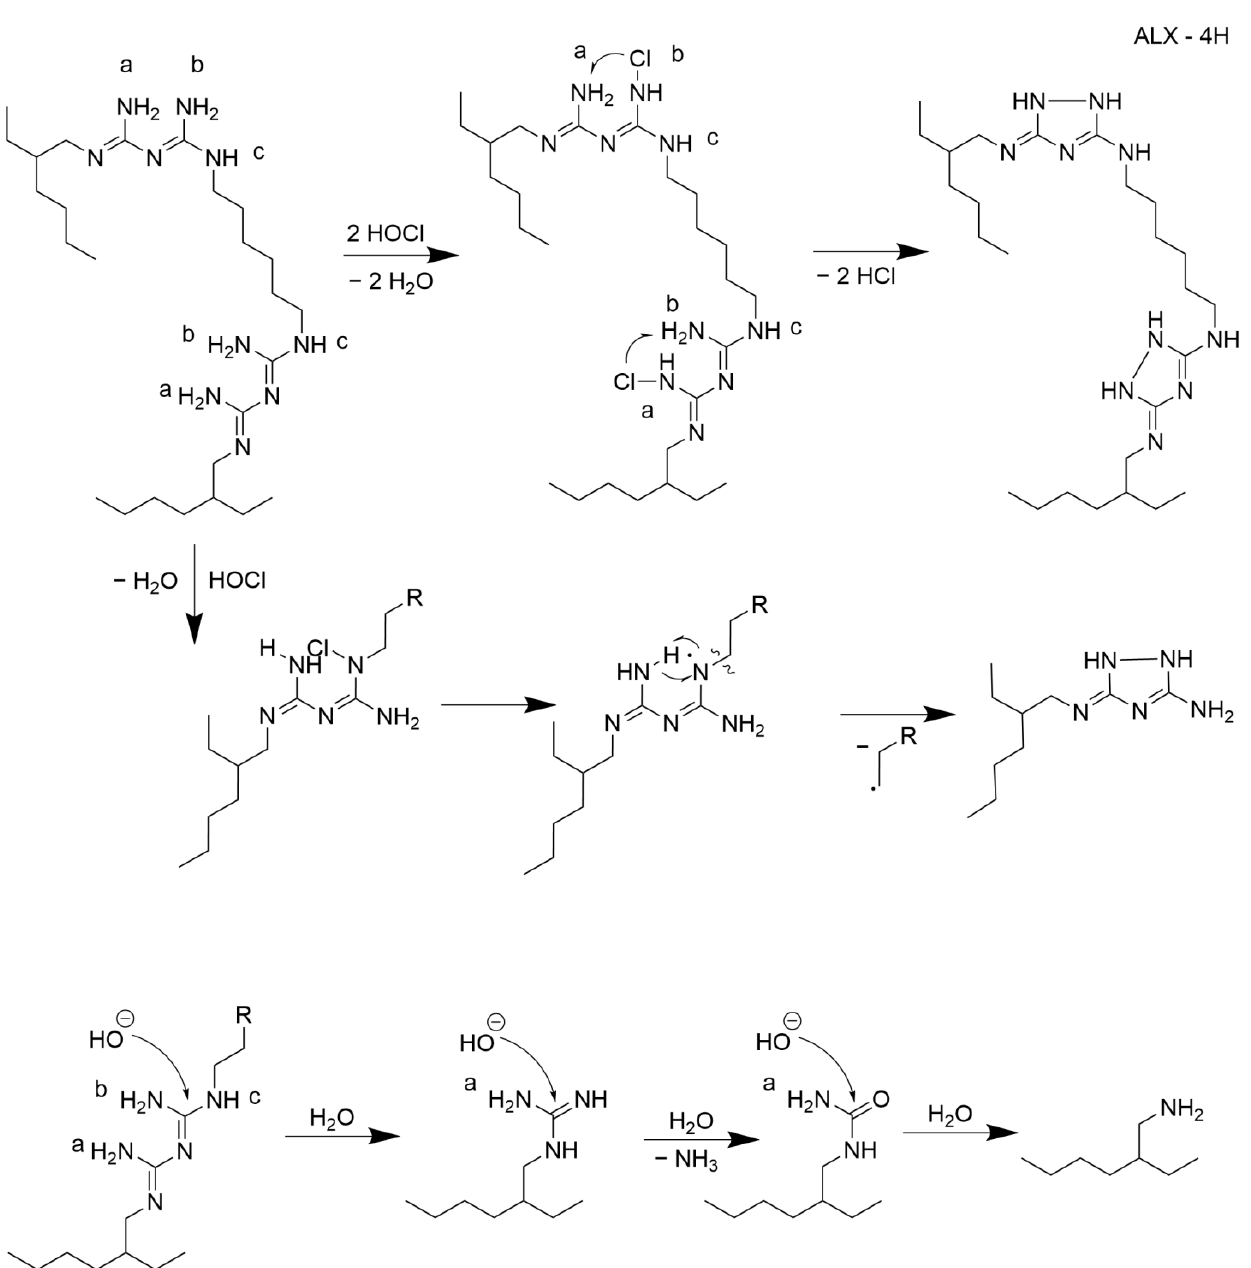
Figure 4. The scheme of reaction mechanism between ALX and NaOCl (the numbers in the brackets correspond with the numbers from Table 1). Letters a, b, and c label nitrogen atoms in the amino groups of guanidine moieties in ALX molecule.